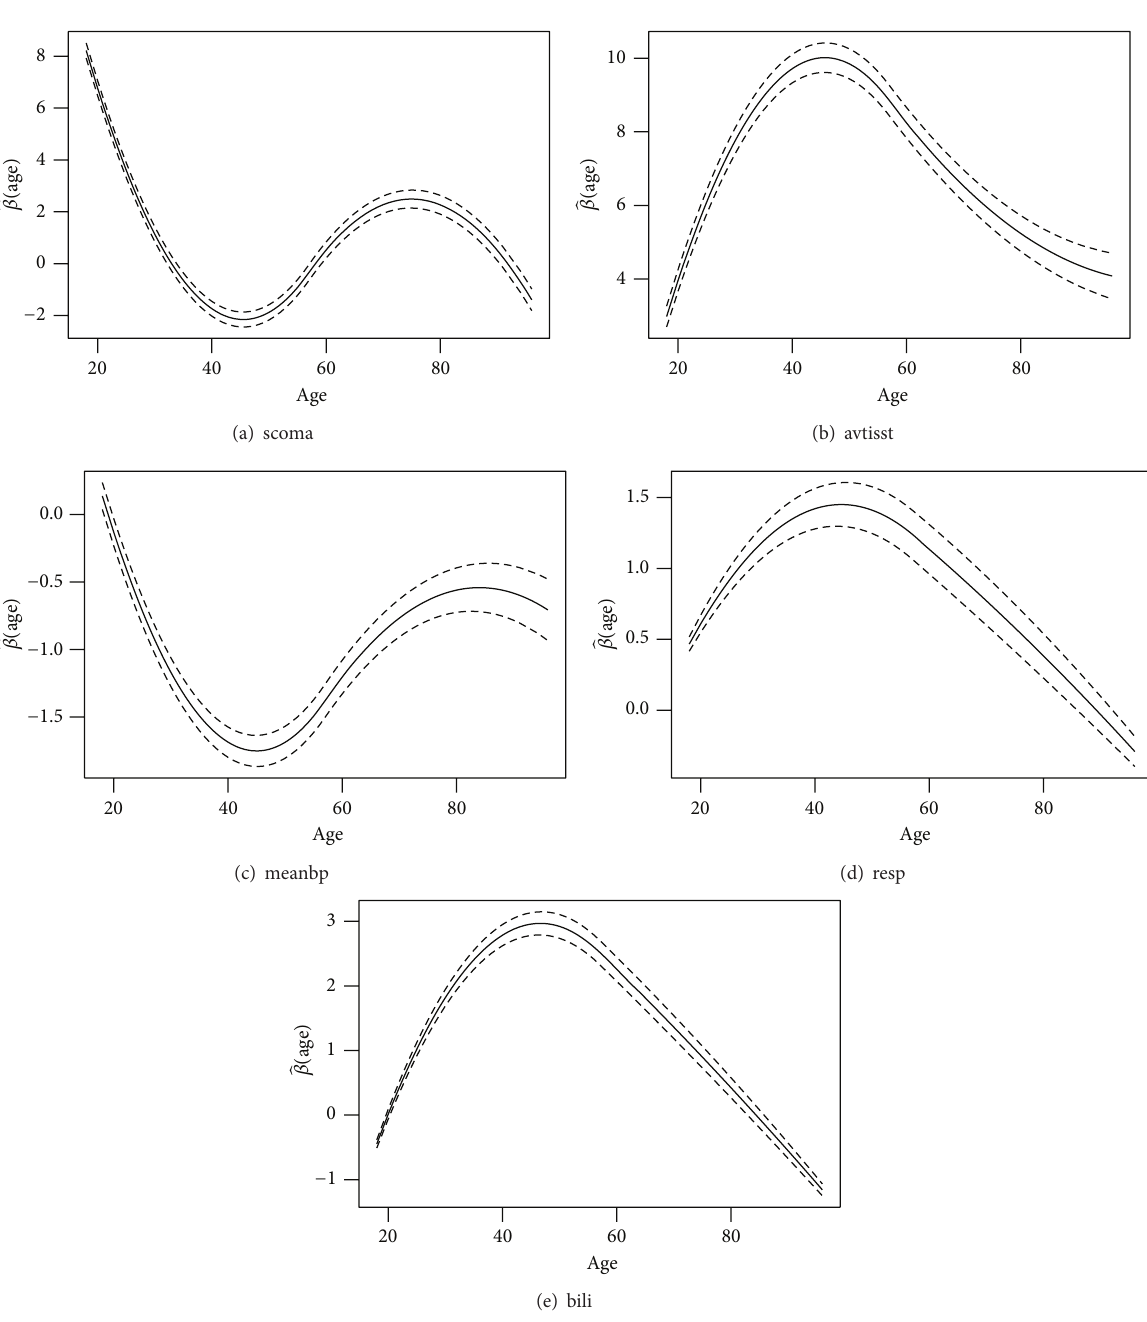
Figure 3: Results of the real data example. The estimated curves of those nonzero functional coefficients. The solid and dashed curves represent the estimated curve and 95% pointwise confidence intervals ( ×10 4